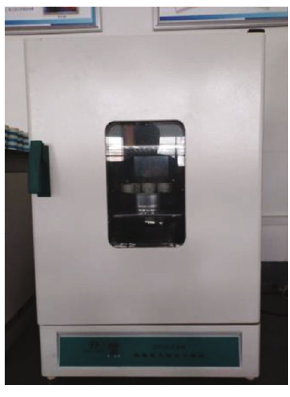
Figure 3: Drying